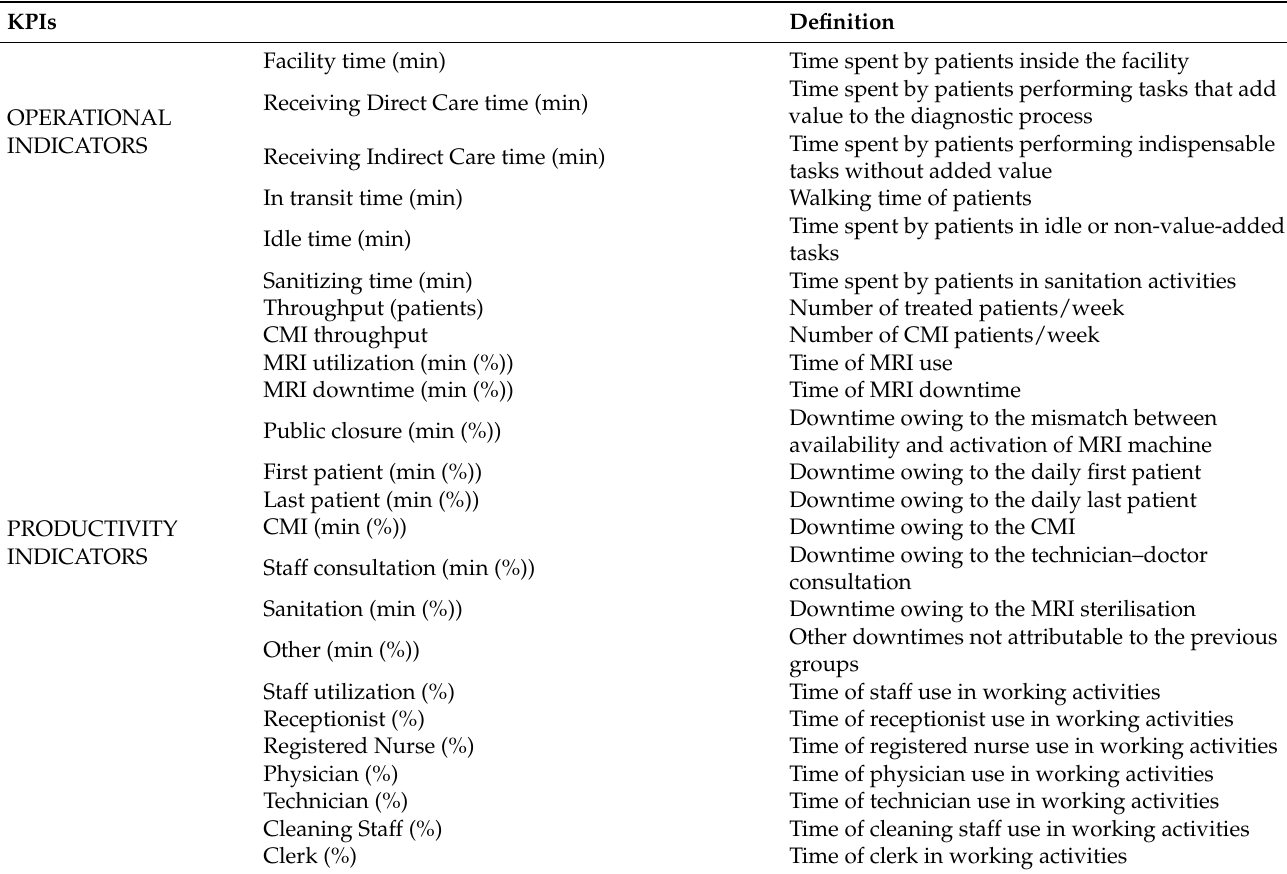
Table 4. KPIs of the GSD SC and their